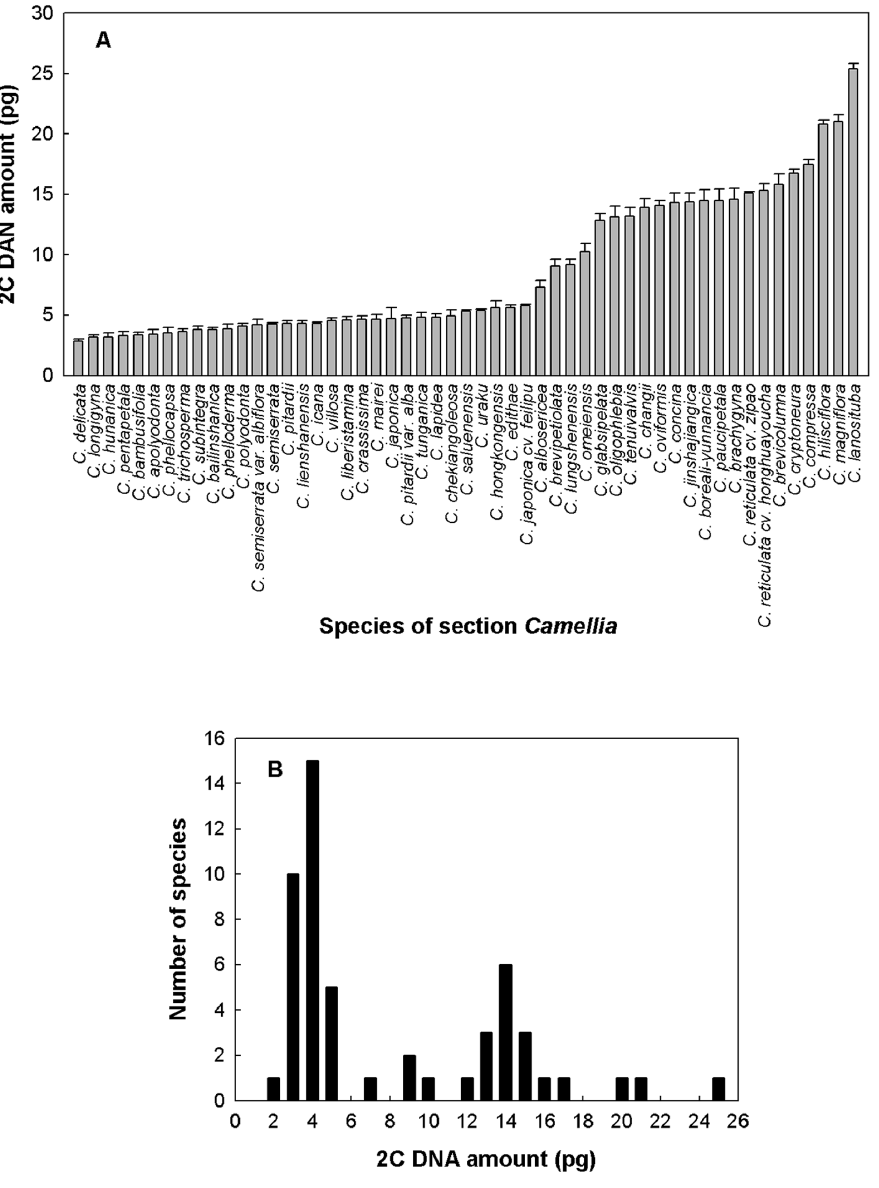
Figure 4. Histograms of the distribution of DNA 2C-values for the 53 species of the section Camellia [ 31 ] . The DNA 2C-values arranged by increasing DNA content (a) and the distribution of DNA 2C-values (b) for the 53 species of the section Camellia